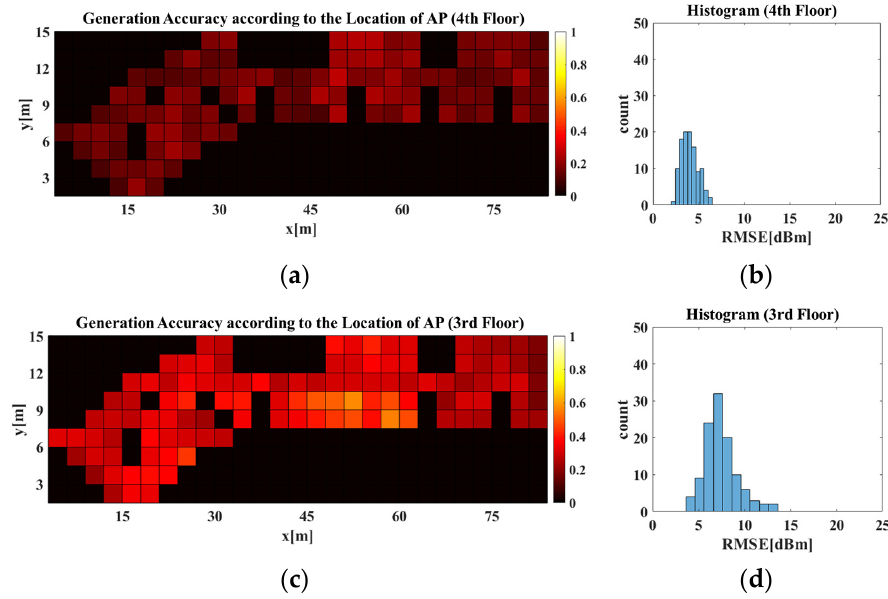
Figure 14. Generation accuracy of predicted ( a , b ) 4th and ( c , d ) 3rd floor radio-map using the RGN trained with 4th floor dataset.